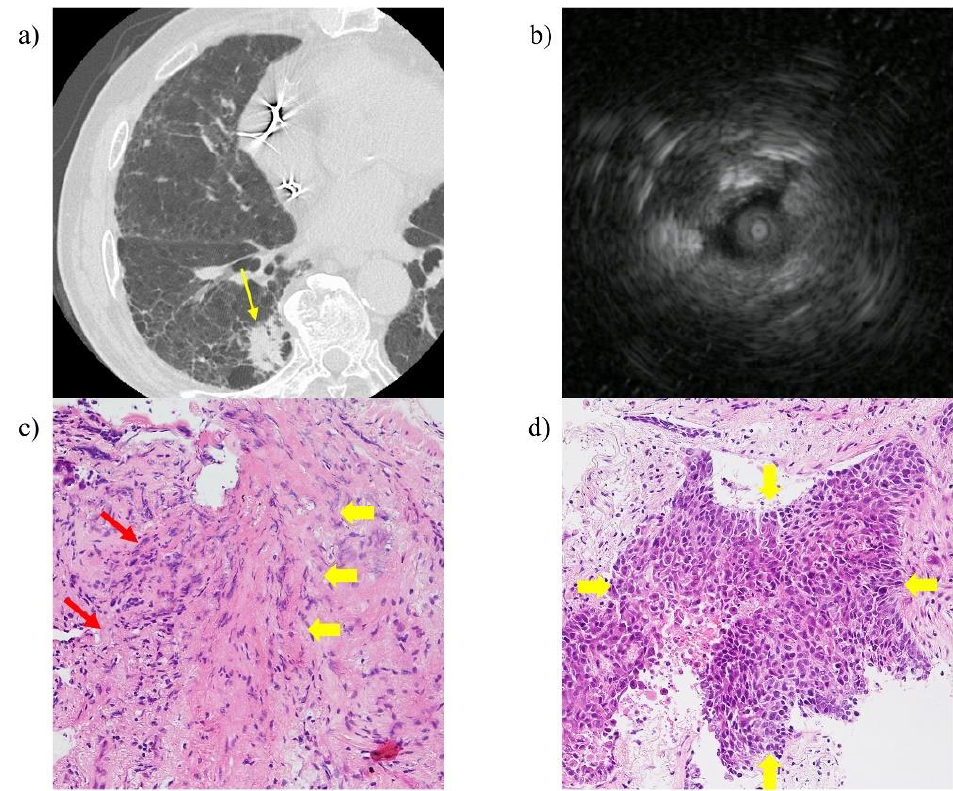
Figure 3. A representative case of a 75-year-old male who was undiagnosed by endobronchial ultrasound with a guide sheath transbronchial biopsy despite collecting samples from a position where the probe is located within the lesion. ( a ) High-resolution computed tomography showed a 28 mm solid nodule (yellow arrow) in the right S6, located near fibrotic lesions. ( b ) The radial endobronchial ultrasound probe was located within the lesion. ( c ) High-power view of the haematoxylin and eosin staining of the specimen obtained by endobronchial ultrasound with a guide sheath transbronchial biopsy showed no malignant cells but inflammatory cells (red arrow) and fibrous thickening (yellow arrow) were present (haematoxylin and eosin staining). ( d ) High-power view of the haematoxylin and eosin staining of the specimen obtained by transthoracic needle biopsy showed malignant cells (yellow arrow).